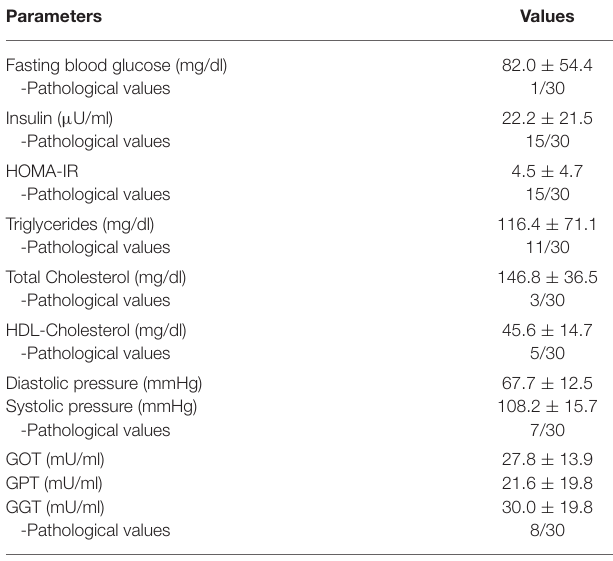
TABLE 1 | Demographic, growth, and clinical features of the enrolled patients. NI patients